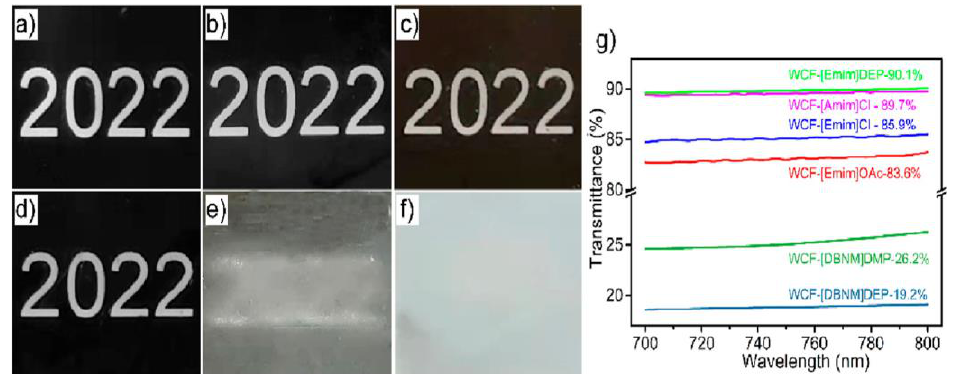
Figure 5. Photographs of wood cellulose films (WCFs) prepared using different ILs: [EMIM]DEP ( a ), [EMIM]OAc ( b ), [EMIM]Cl ( c ), [AMIM]Cl ( d ), [DBNM]DMP ( e ), [DBNM]DEP ( f ), and trans- mittance values at 800 nm ( g ) (reprinted with permission from [60]. Copyright © 2022, American Chemical